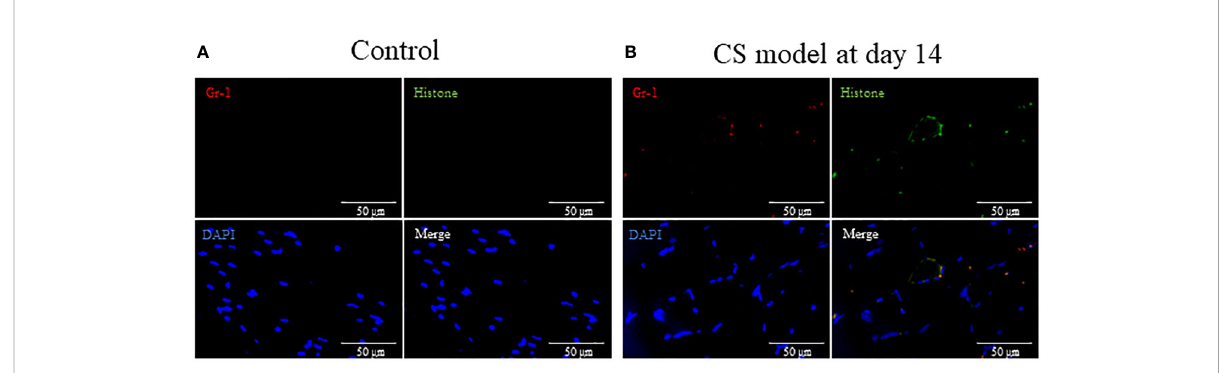
FIGURE 5 Sepsis induces NETs in muscle in mice. (A) In tibialis anterior muscle section, neutrophils, degranulation, and the nucleus are stained by Gr-1 (red), histone (green), and DAPI (blue), respectively. Gr-1, histone, and DAPI colocalization represent NETs. (A) No NETs were found in the control group. (B) At 14 days after CS injection, NETs were visually observed in the CS model. NETs: neutrophil extracellular traps, DAPI: 6-diamidino-2-phenylindole. n = 1 in each